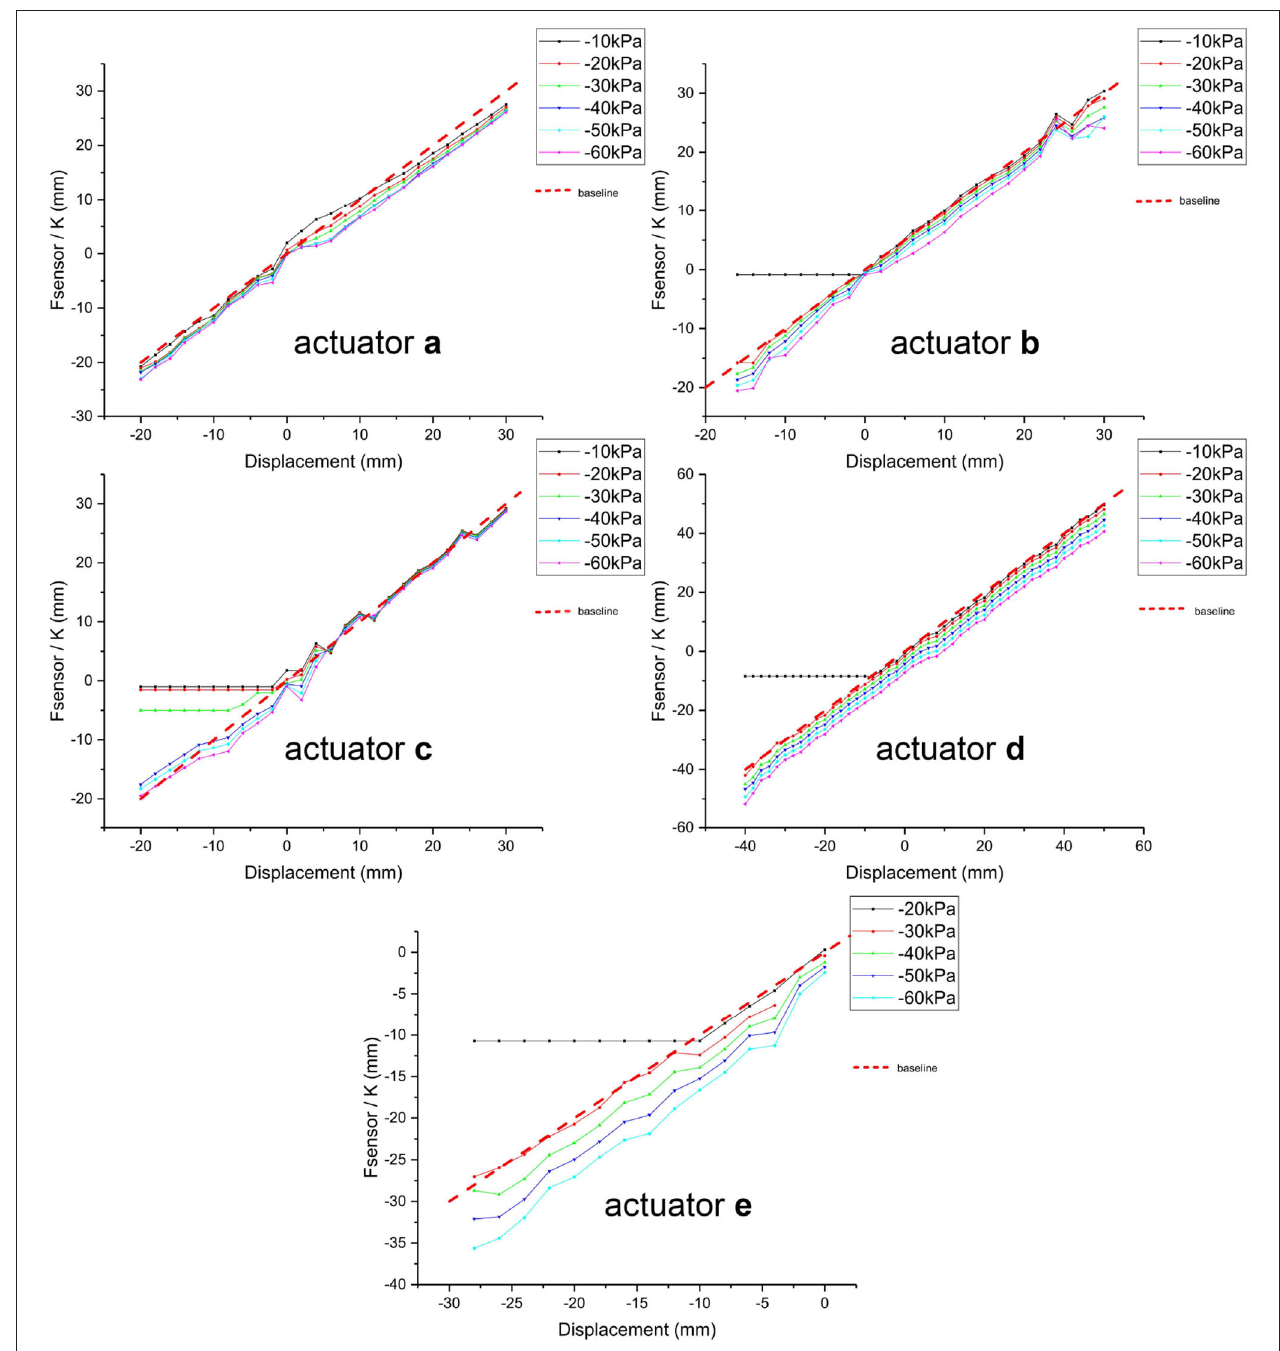
FIGURE 5 | Accuracy of five actuators under quasi-static equilibrium. The displacement detection error of the sensor is represented by the distance between experimental data points and the reference line in the vertical direction. Negative value of the abscissa indicates that the actuator is in contraction state, while positive value means stretching state. Horizontal experimental data line indicates that the actuation force is too weak to actuate the SPCAM, leading to the relaxed state.